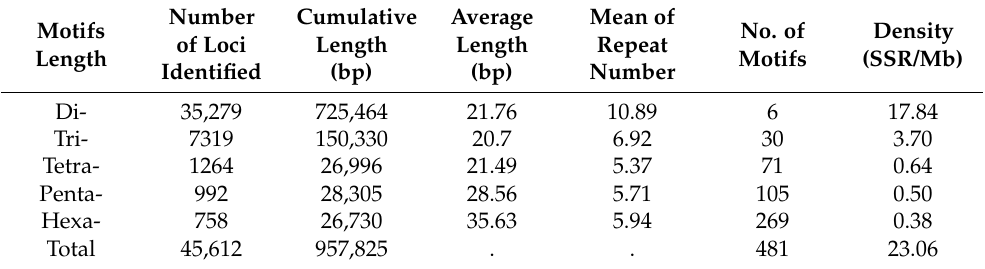
Table 2. The distribution of SSR loci in the genomic sequences of M. incana